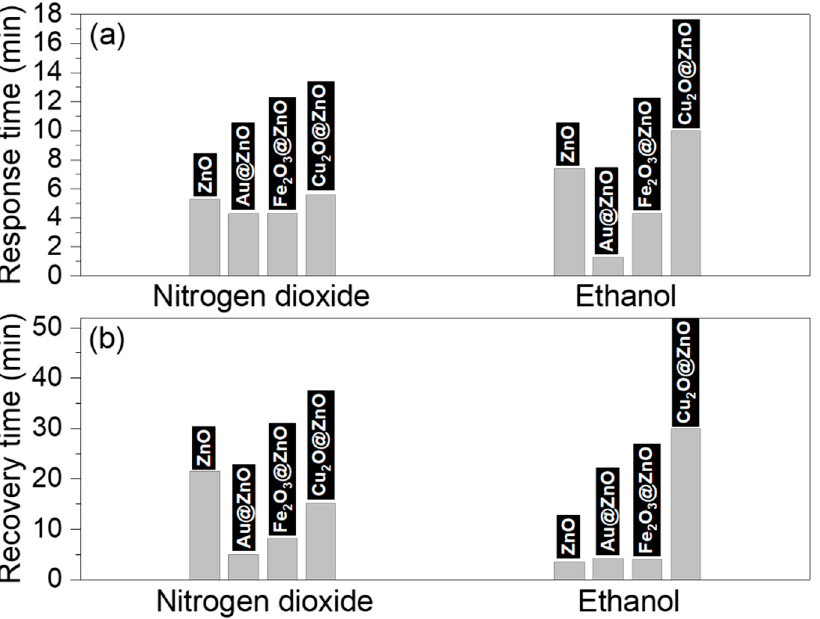
Figure 13. ( a ) Response and ( b ) recovery times to 1 ppm of nitrogen dioxide and 20 ppm of ethanol recorded with the non-modified and modified ZnO structures.